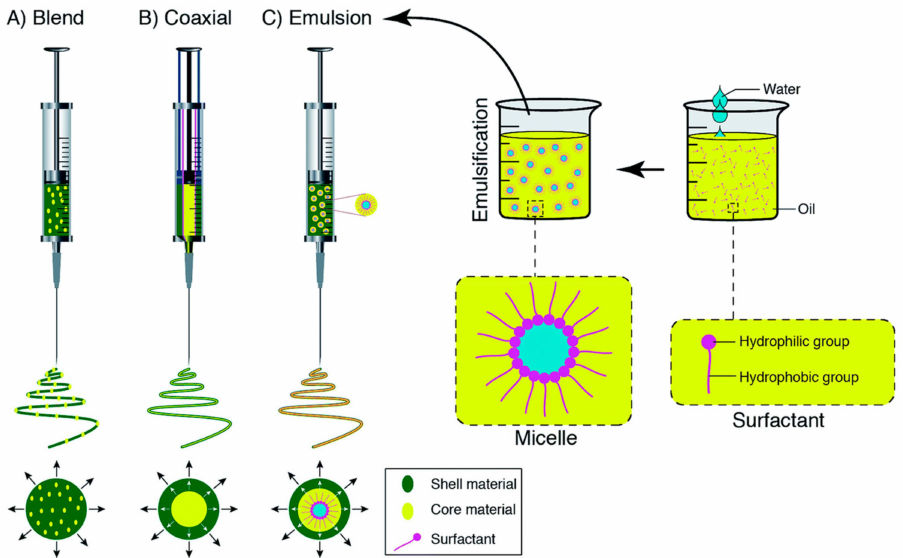
Figure 13. The di ff erence in the loading of the polymer feed solution between blend, coaxial, and emulsion electrospinning and the di ff erence in the resulting structure of the nanofibers. Reprinted with permission from [67], The Royal Society of Chemistry,